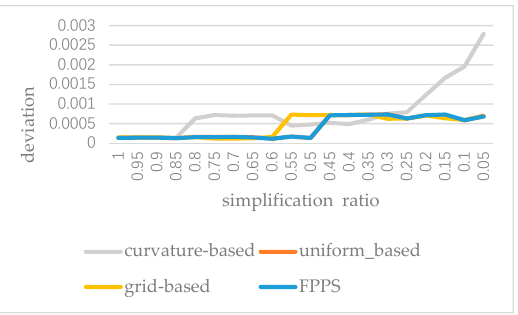
Figure 13. The reconstructed surface deviation with a decrease in the simplification ratio by four simplification algorithms.